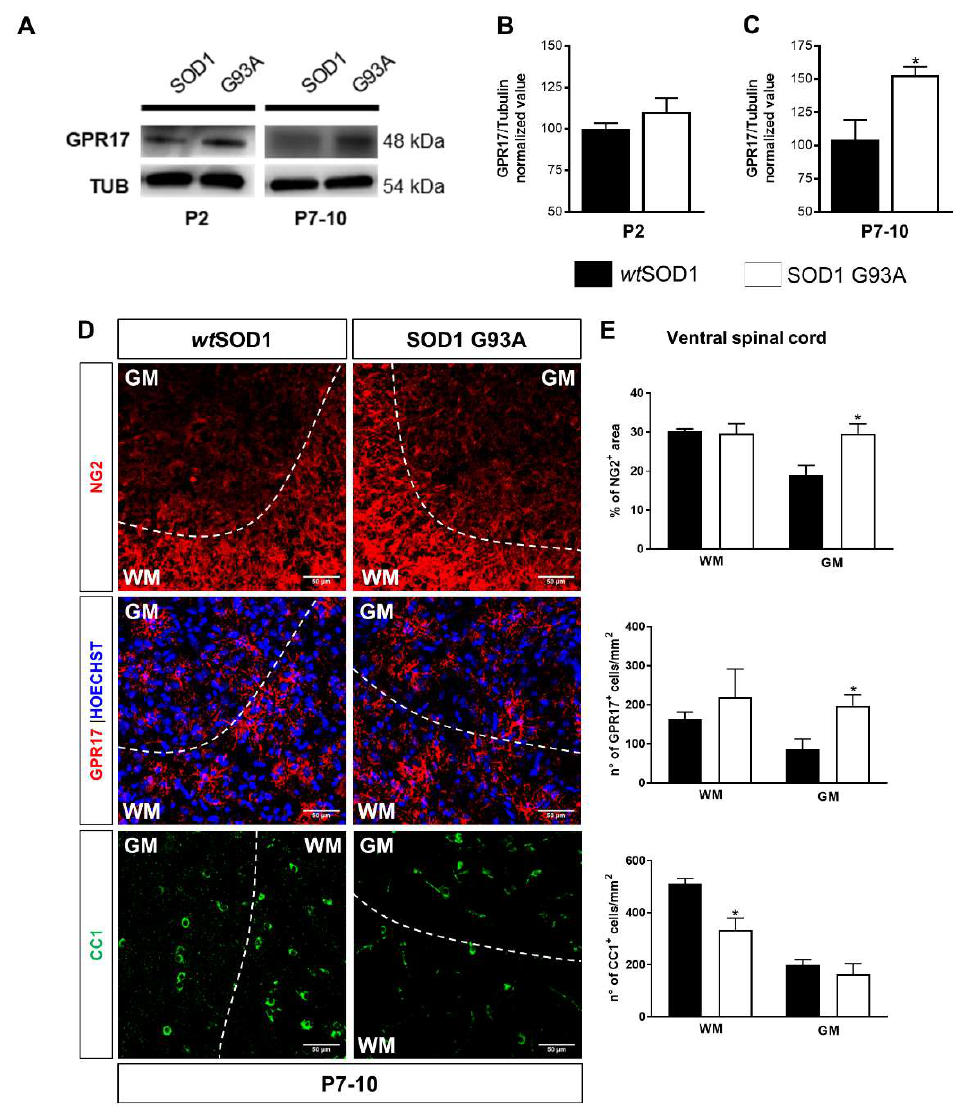
Figure 3. Increase of GPR17 and NG2 expression and impaired oligodendroglial maturation in the developing spinal cord of SOD1 G93A mice. ( A – C ) Representative images and quantifications of GPR17 protein levels analyzed by western blot in the total spinal cord of wt SOD1 and SOD1 G93A mice at developmental stages P2 and P7-10. Histograms show the results of densitometric analysis, data are expressed as mean ± SE. ( n = 7 wt SOD1 mice and n = 5 SOD1 G93A mice); * p < 0.05, compared to wtSOD1, non-parametric Mann–Whitney test. ( D ) Representative images of NG2, GPR17, and CC1 staining in the ventral spinal cord of wt SOD1 and SOD1 G93A mice at P7-10. Dashed line separates white matter (WM) and grey matter (GM). Scale bar: 50 µm. ( E ) Histograms show results of the densitometric analysis of the NG2 staining and of GPR17 and CC1 cell density in WM and in GM of ventral spinal cord ( n = 3). * p < 0.05 SOD1 G93A vs wt SOD1; Student’s t -test.